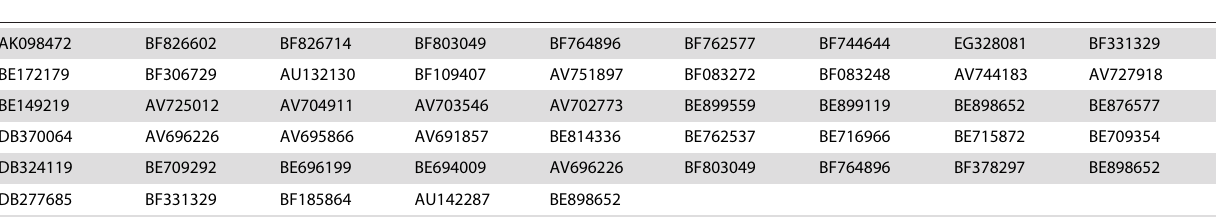
Table 2. ESTs that contain a sequence with mulitple repeats in nuclear